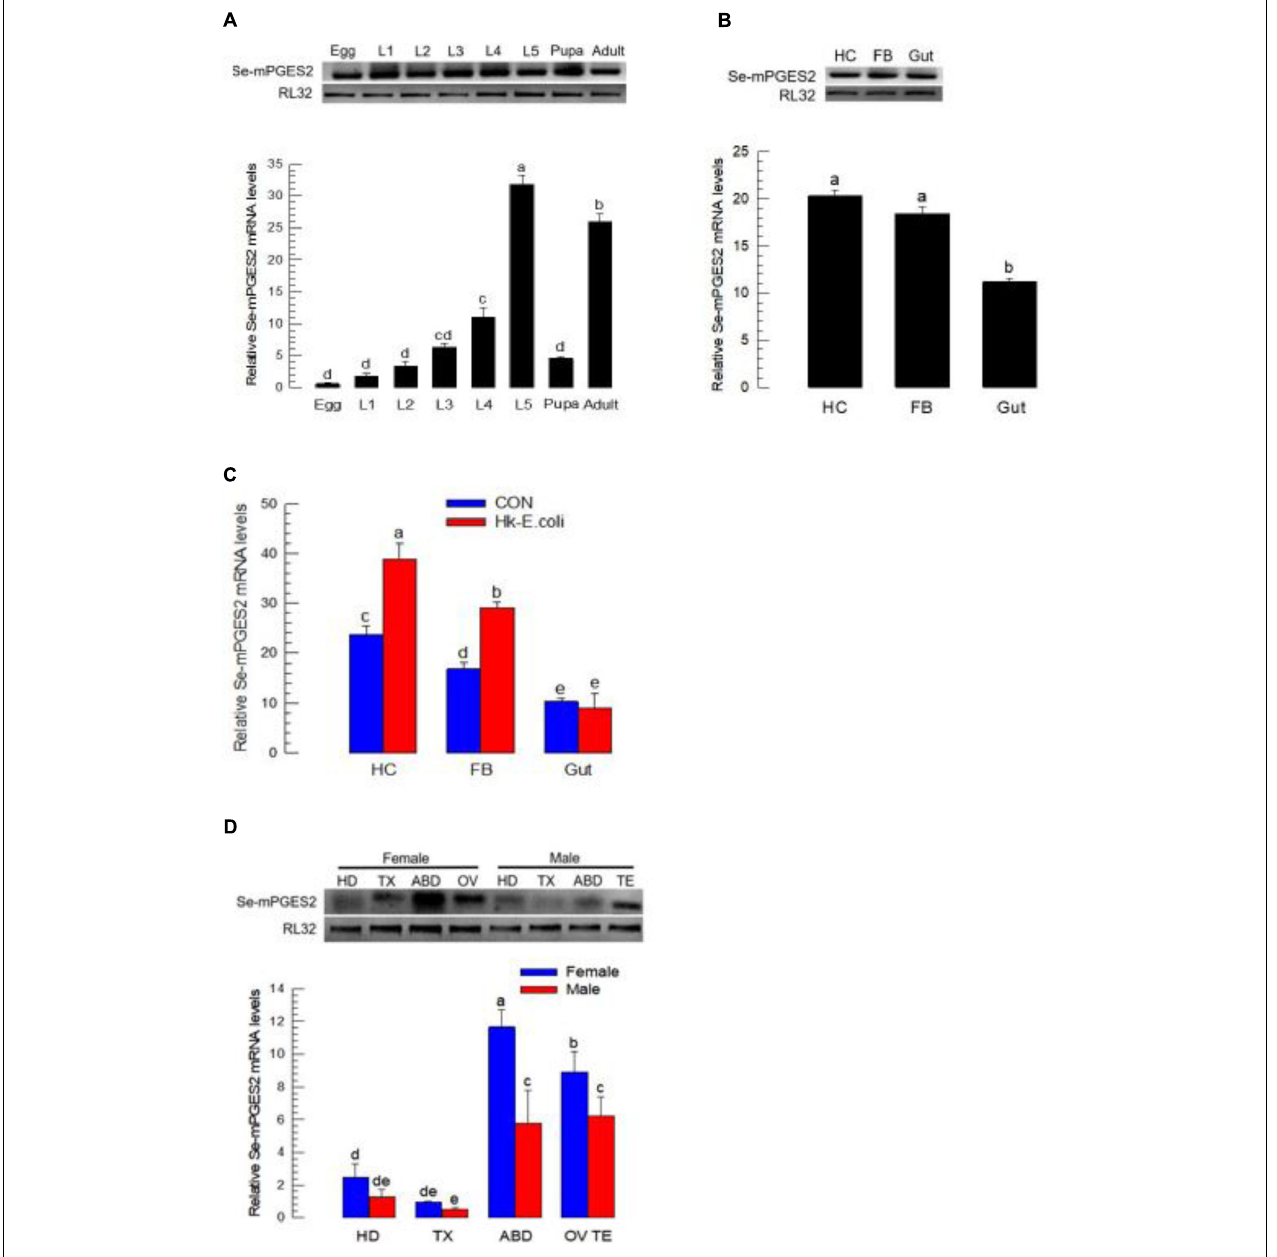
FIGURE 2 | Expression profile of Se-mPGES2 . (A) Expression patterns in different developmental stages: egg, first to fifth instar larvae (“L1–L5”), pupa, and adult. (B) Expression patterns in indicated tissues of L5 larvae: hemocyte (“HC”), fat body (“FB”), and midgut (“Gut”). (C) Induction of Se-mPGES2 in response to bacterial challenge. Heat-killed E. coli was injected into L5 larvae and incubated for 12 h at 25 ◦ C. (D) Expression patterns in indicated body parts of adults: head (“HD”), thorax (“TX”), abdomen (“ABD”), ovary (“OV”), and testis (“TE”). A ribosomal gene, RL32, was used as reference gene. Each treatment was replicated three times with independent tissue preparations. Different letters indicate significant differences among means at Type I error = 0.05 (LSD